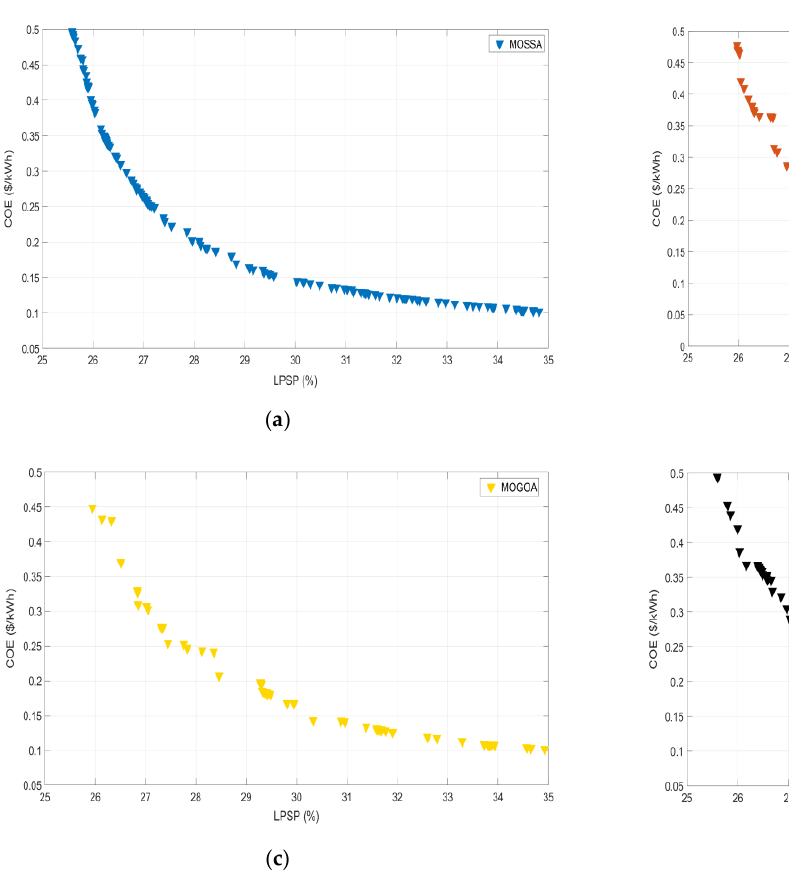
Figure 12. Pareto front of stand-alone microgrid system considering LPSP and COE. ( a ) MOSSA; ( b ) MODA; ( c ) MOGOA; ( d ) MOALO. MODA; ( c ) MOGOA; ( d )